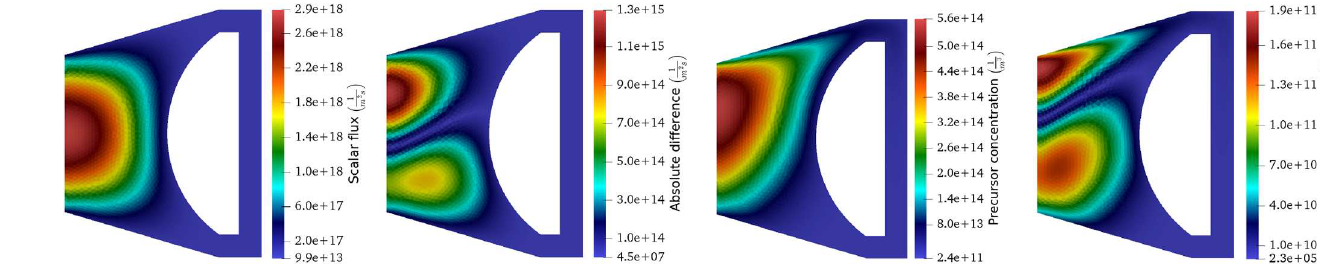
Fig. 3. The reduced order solution for the scalar flux in energy group one together with its absolute deviation from the full order solution.